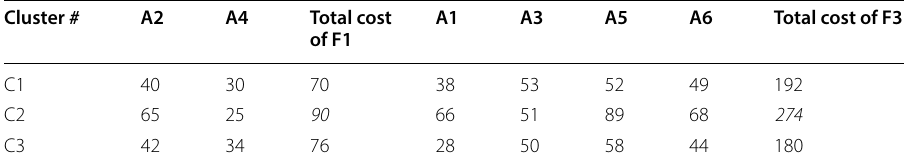
Table 19 Scenario (2)—Decision Making Matrix Cluster #